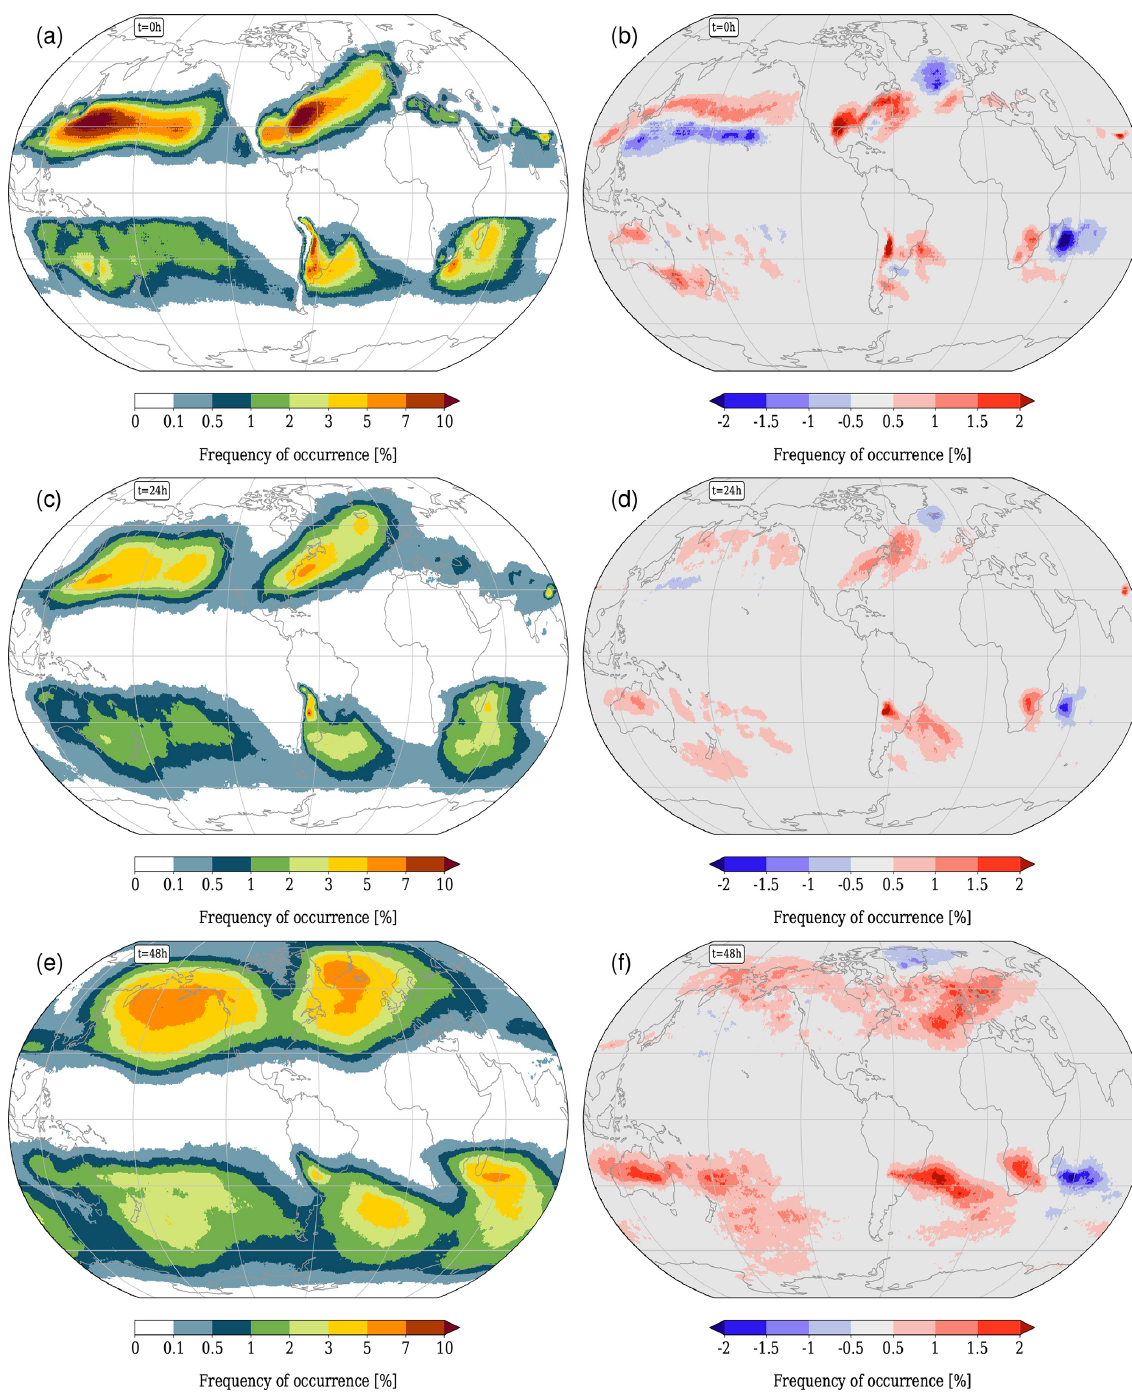
Figure 4. Absolute values of WCB frequencies (in %) for HIST (a, c, e) and difference RCP8.5 − HIST during boreal winter (DJF) for WCB ascent times t = 0h (a, b) , t = 24h (c, d) , and t = 48h (e, f)